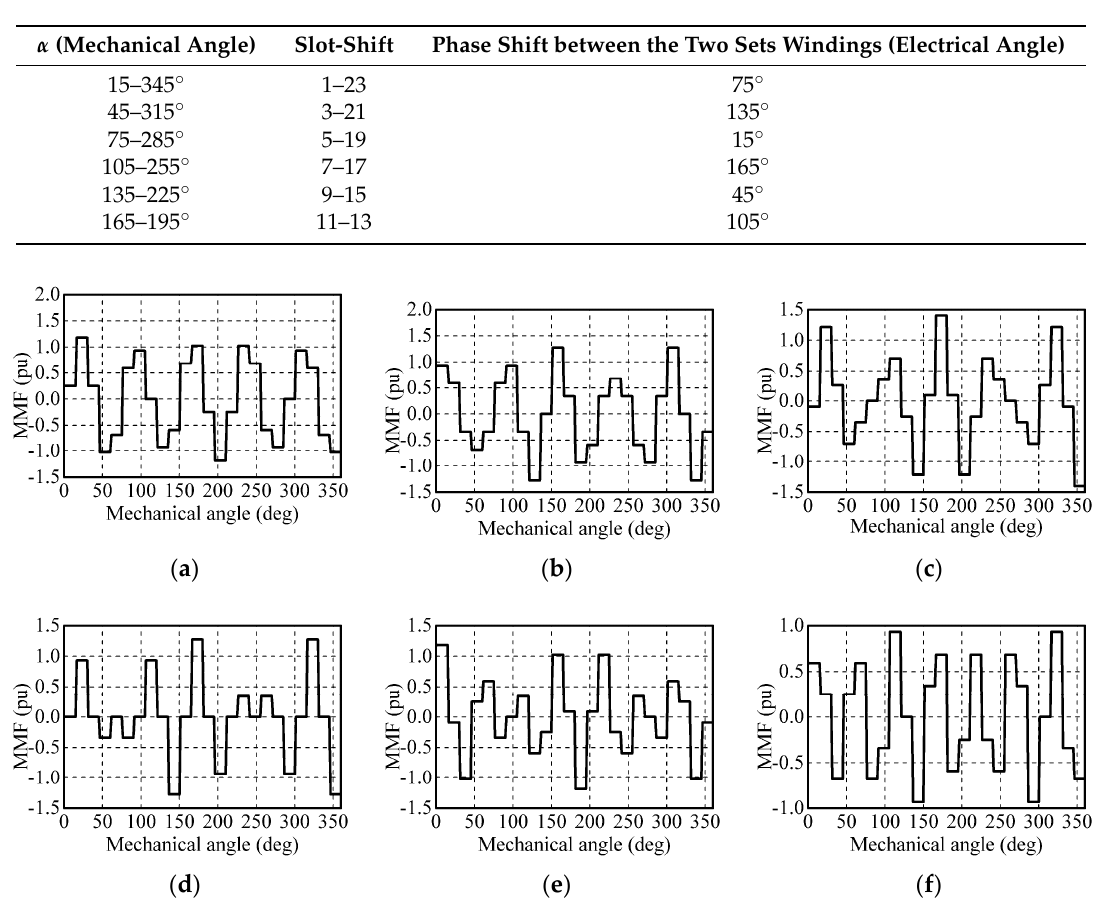
Table 2. Possible phase shifts in the 24-slot/10-pole six-phase winding layout.